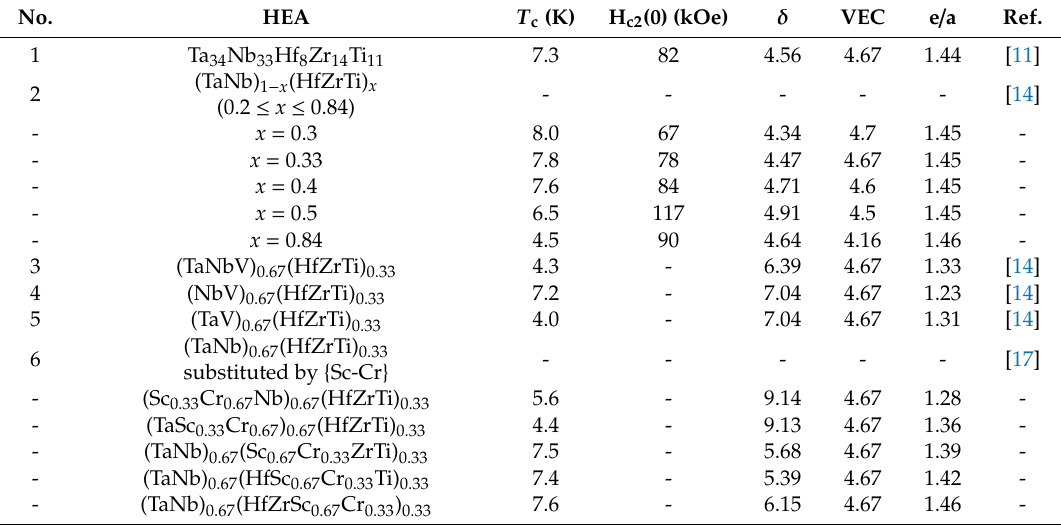
Table 1. Superconducting properties, δ , valence electron count (VEC) and average number of itinerant the references listed in the